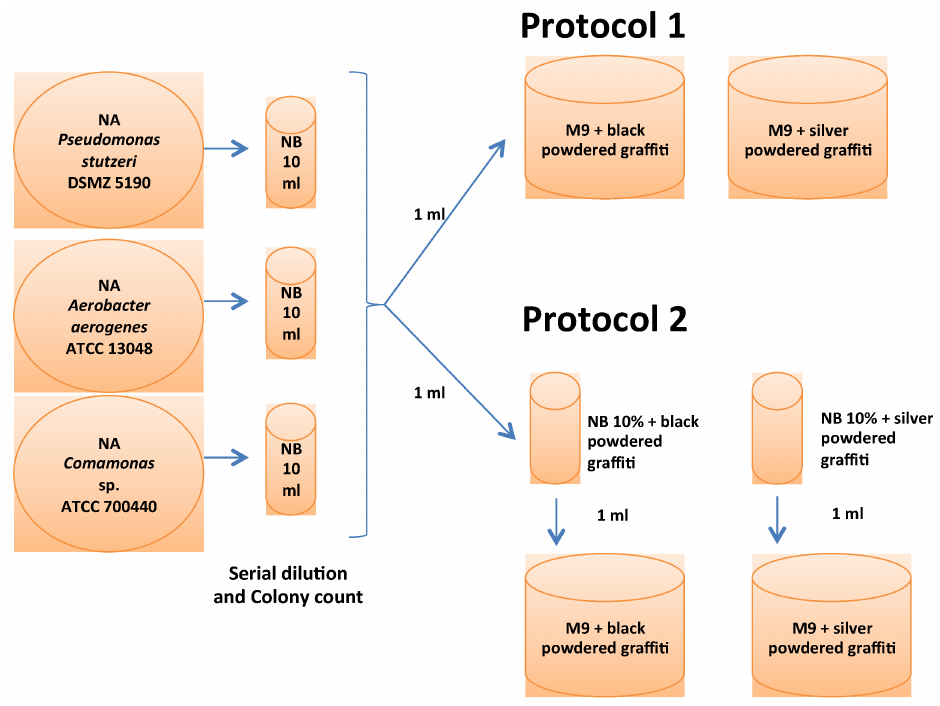
Figure 1. Schematic diagram of the experimental set-up for testing the culture